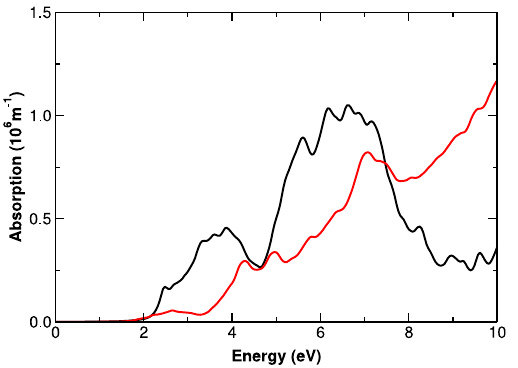
Figure 9. Calculated absorption spectra for CaMnO 3 (black) and Pr 0.5 Ca 0.5 MnO 3 (red). The absorption edge from 2 eV to 4 eV is attributed to the occupation of the Mn e g states, which demonstrate the lowering of the absorption intensity due to doping in Pr 0.5 Ca 0.5 MnO 3 , while they are empty and thus visible in the spectrum of CaMnO 3 .